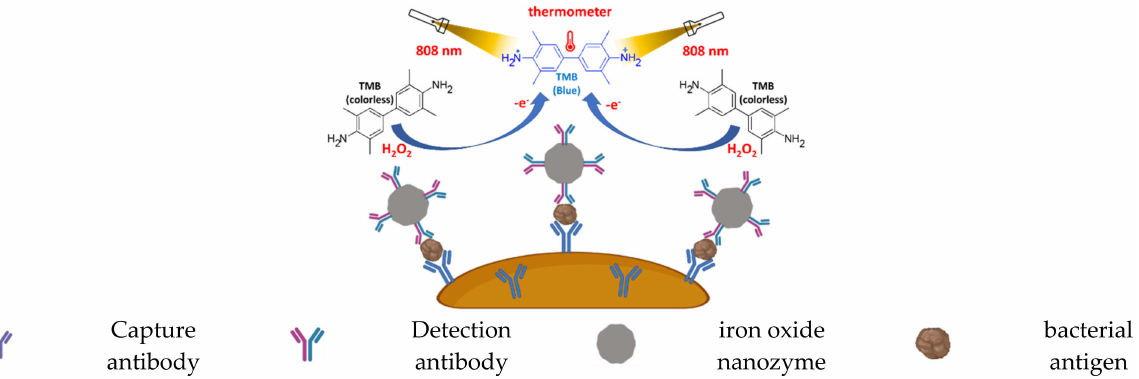
Figure 10. Illustration of the colorimetric photothermal nanozyme-linked immunoassay (redrawn from ref Alizadeh et al.,